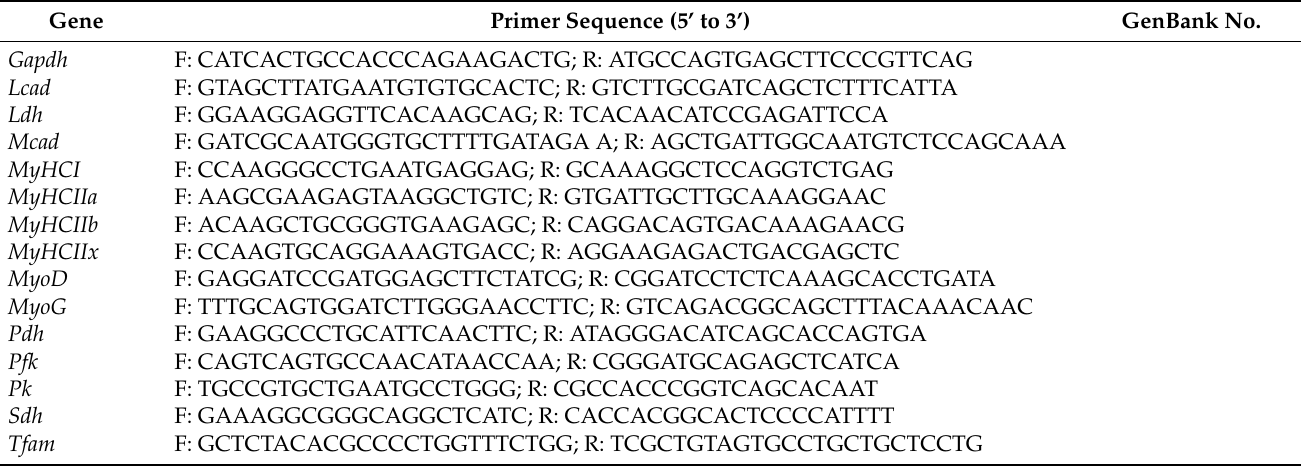
Table 1. Cont. Primer Sequence (5’ to